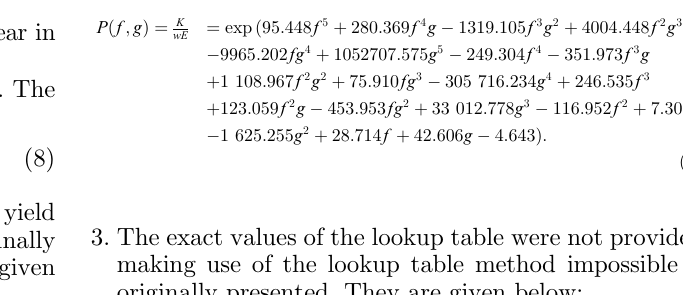
Table 5. Lookup table exact values: K